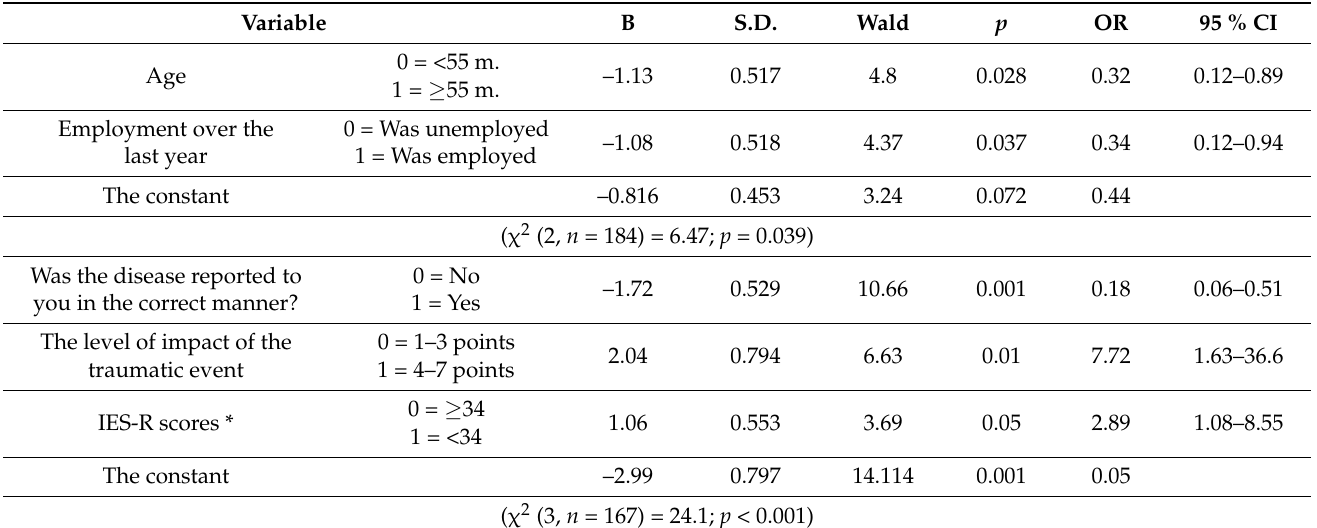
Table 4. Risk factors for suicidal ideation symptoms after surgery ( n = 188).